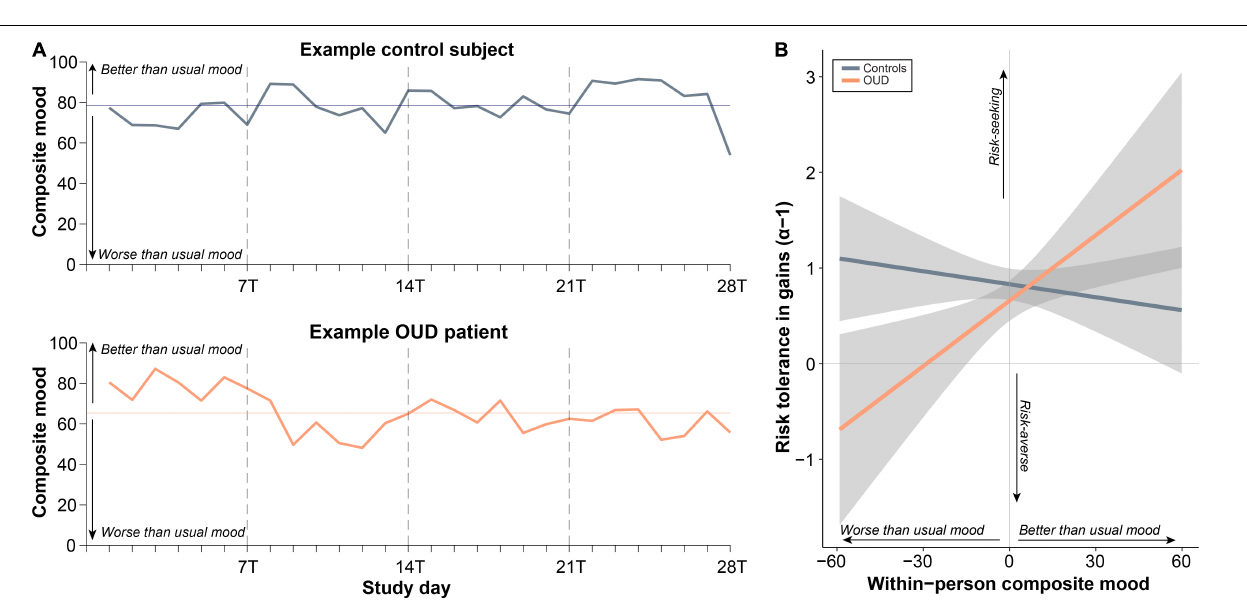
FIGURE 4 | Diagnostic group differences in aggregate level decision-making parameters. (A) Aggregate-level risk tolerance and (B) ambiguity tolerance in both gains and losses were comparable between people with opioid use disorder (OUD) and matched controls. By contrast, (C) patients had higher discount rates overall than controls. Dots represent individual subject averaged data across the 28 study days. Shaded regions represent a density plot of subjects’ averaged risk and time preferences. Diamonds indicate group medians. * P = 0.006.